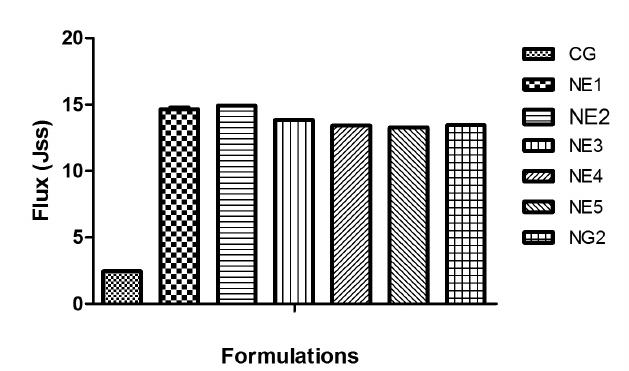
FIGURE 3 - Percentage of cumulative drug permeation for the various nanoemulsions through human cadaver skin.